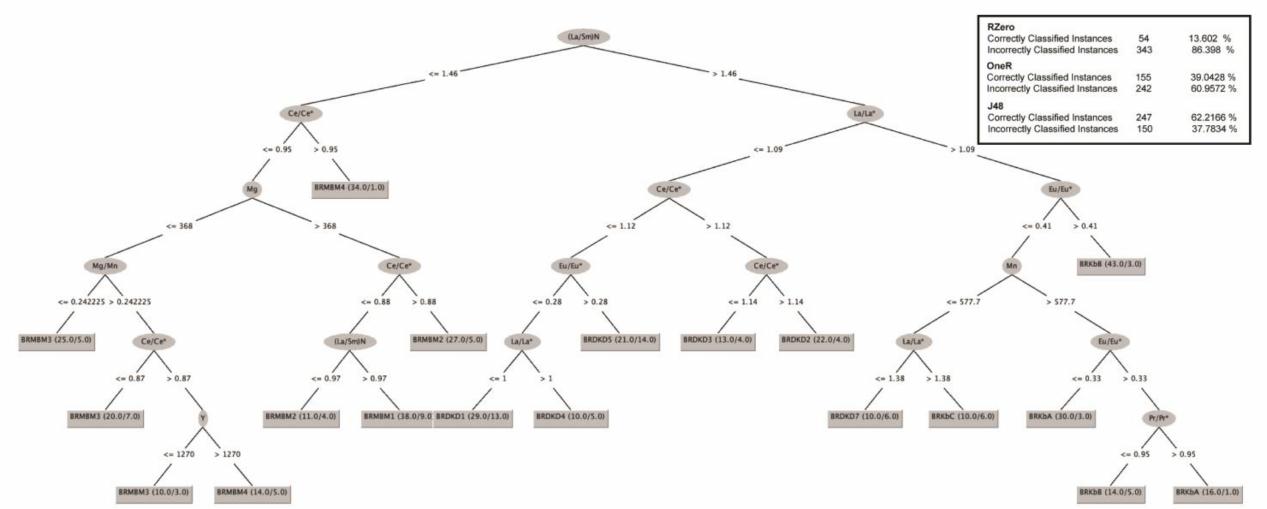
Figure 5. Big-Ridge-Model decision tree of five Ordovician K-bentonites exposed in outcrop at Big Ridge using the J48 classifier. Shown in the inset are the percentages for correctly and incorrectly classified instances based on different decision modes. RZero: essentially guessing the most abundant class for every instance; OneR: classifying each instance based on only one